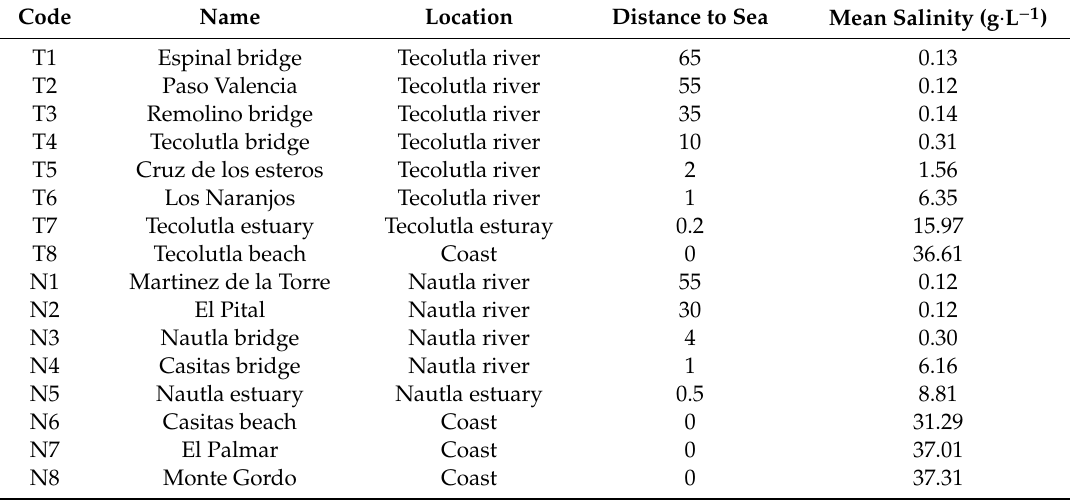
Table 1. Codes and locations of the monitoring sites used in this study and provided by the local government. Mean salinity was calculated with 4 measurements during 2016 provided by the local